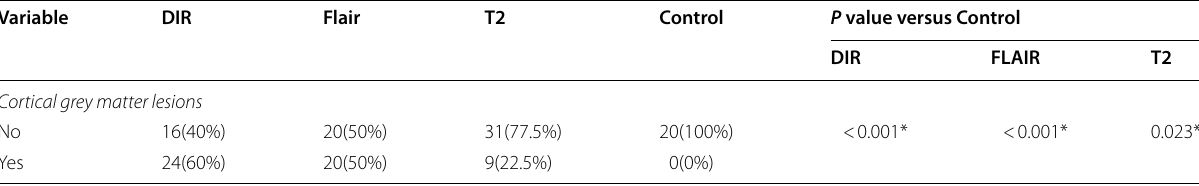
Table 7 Comparison between different MRI sequences (T2, Flair and DIR) among studied 40 MS patients versus controls as regarding detection rate of cortical grey matter lesions